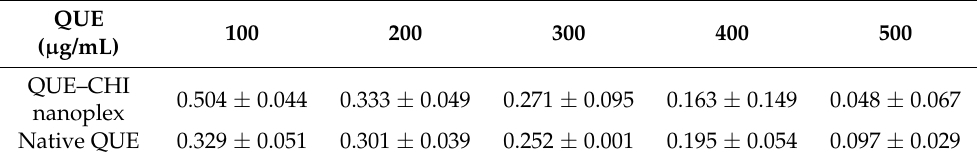
Table 1. OD 600 values were observed at different QUE concentrations.